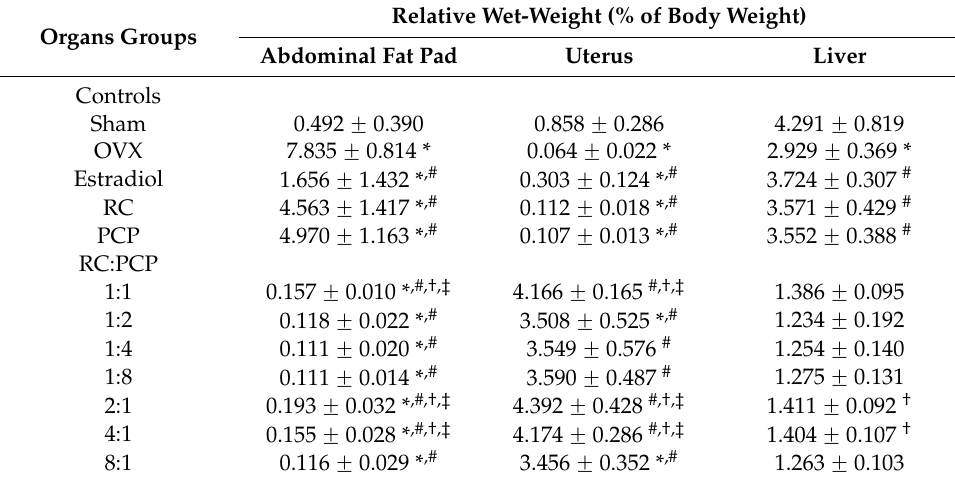
Table 3. Abdominal fat pad, uterus and liver weights in sham-operated or OVX ddY